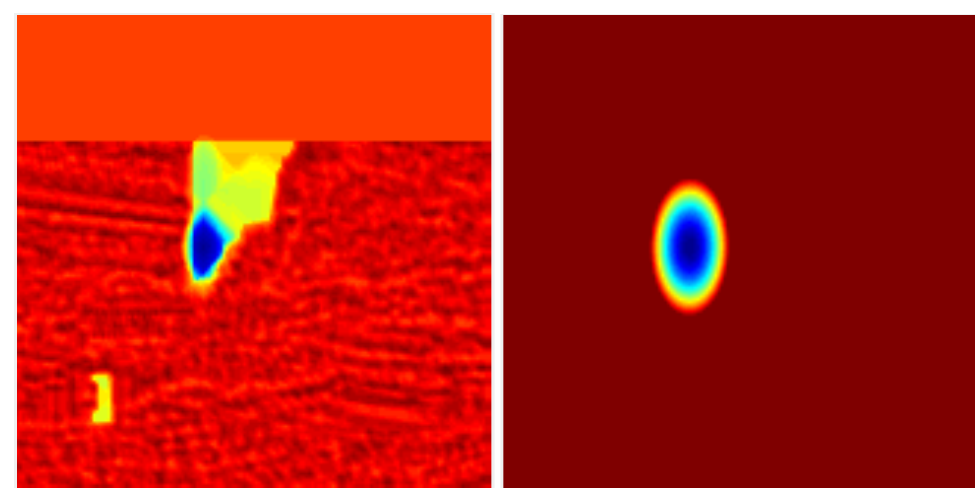
Figure 3. Uncertainty fitting of negative logarithm of a bivariate Gaussian to a matching cost slice (after spatial smoothness regularisation step). From left to right: ( left ) 2D cost slice, ( right ) the approximate 2D cost slice using a 2D Gaussian